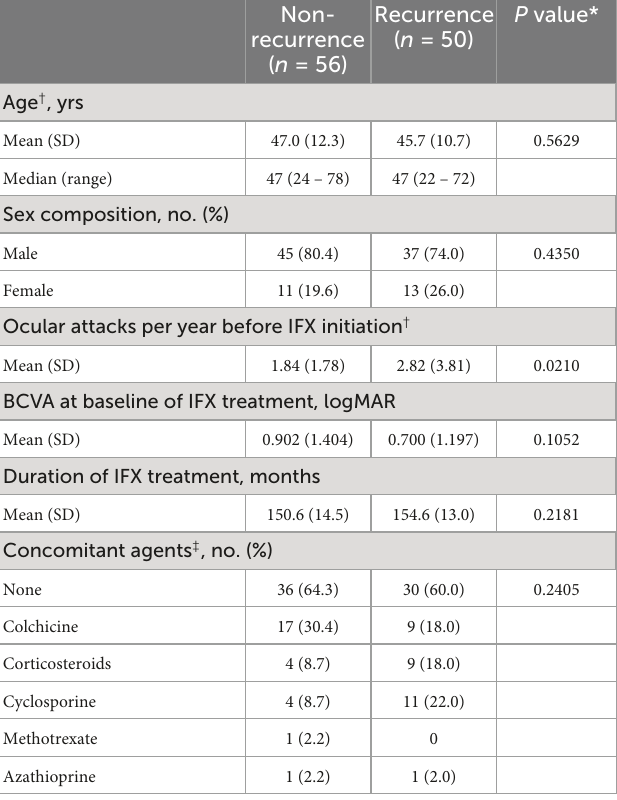
TABLE 4 Characteristics of Behçet disease uveitis patients with or without recurrence of uveitis after infliximab treatment